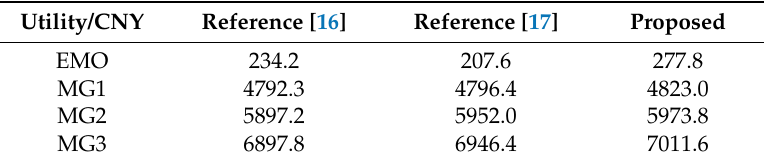
Table 3. Comparisons with other methods.